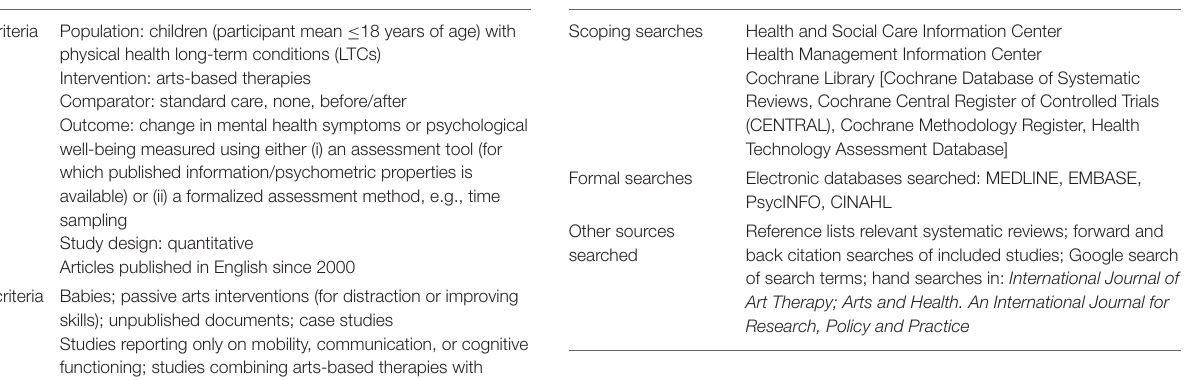
TABLE 1A | Inclusion